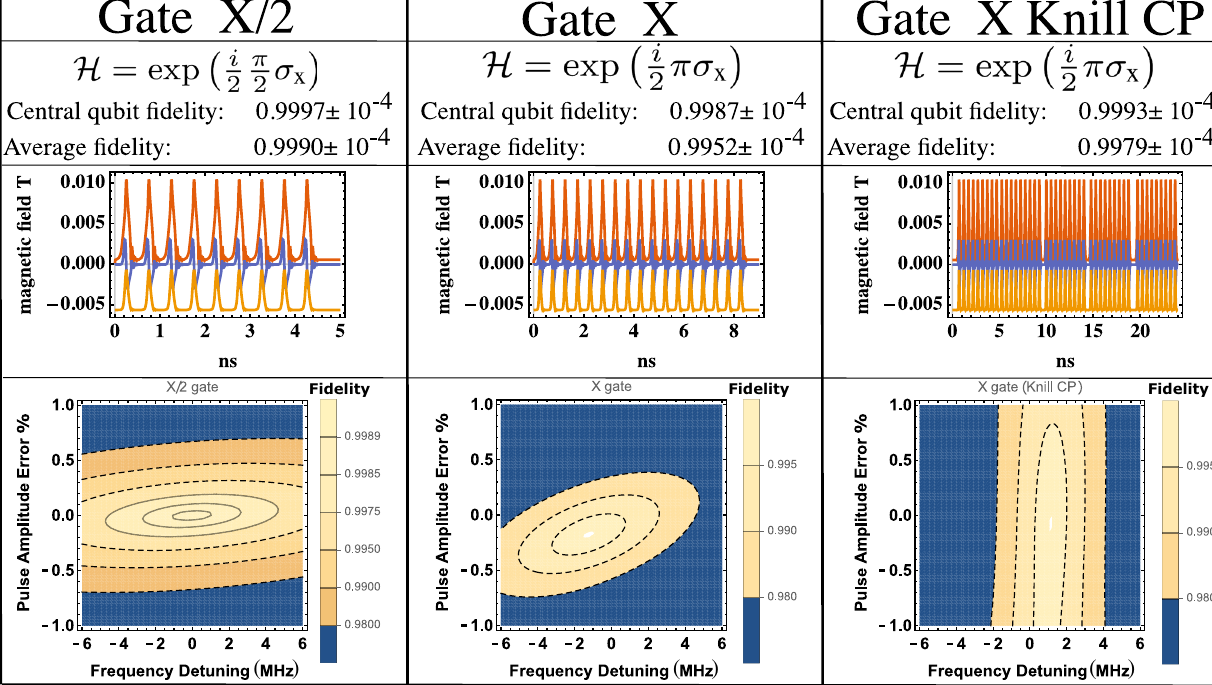
Fig. 6 Implementation of quantum gates using nanomagnets driven at 2 GHz. Each column represents the one-qubit gate indicated in the fi rst row. The second row shows the gate fi delity for the central qubit along with the average fi delity for gate implementation for all 25 qubits at the qubit volume. The uncertainty in fi delity is estimated based on variations (spatial inhomogeneity) of the effective fi eld. The third row is a depiction of the induced magnetic fi eld pro fi le for the central qubit, where B B B x , y , z components are presented with red, blue and orange lines, respectively. The fourth row indicates contour plots of average gate fi delity, evaluated for frequency detuning and pulse amplitude errors. The color bar shows the average gate fi delity in each contour and the solid lines circumscribe the area where the error per gate is smaller than 3 × 10 − 3